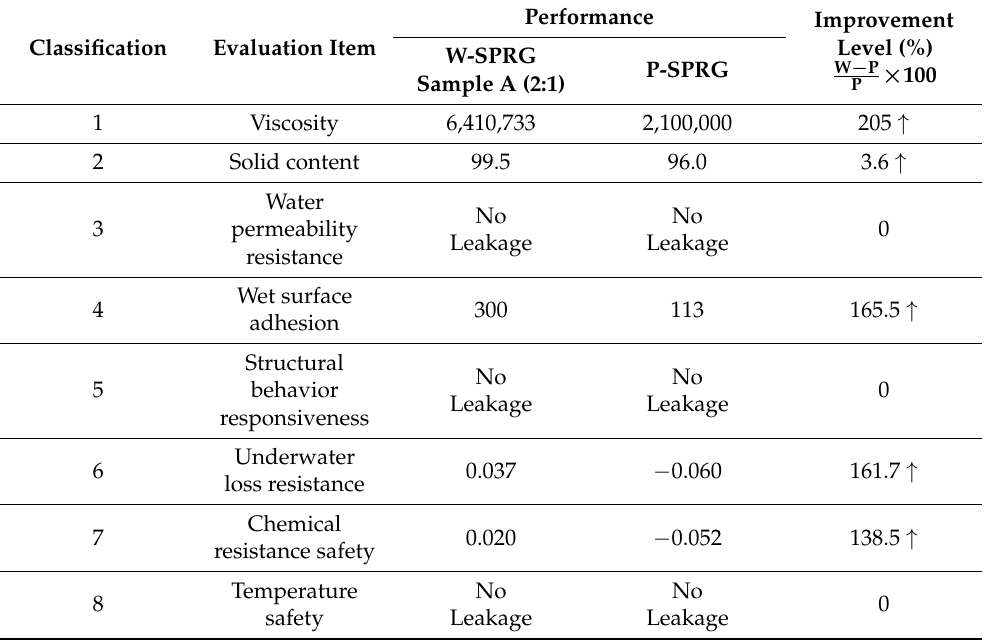
Table 9. Comparative analysis of performance improvement of W-SPRG compared to P-SPRG.